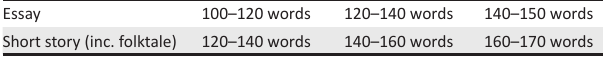
TABLE 1: Text length stipulated in the curriculum (National Curriculum